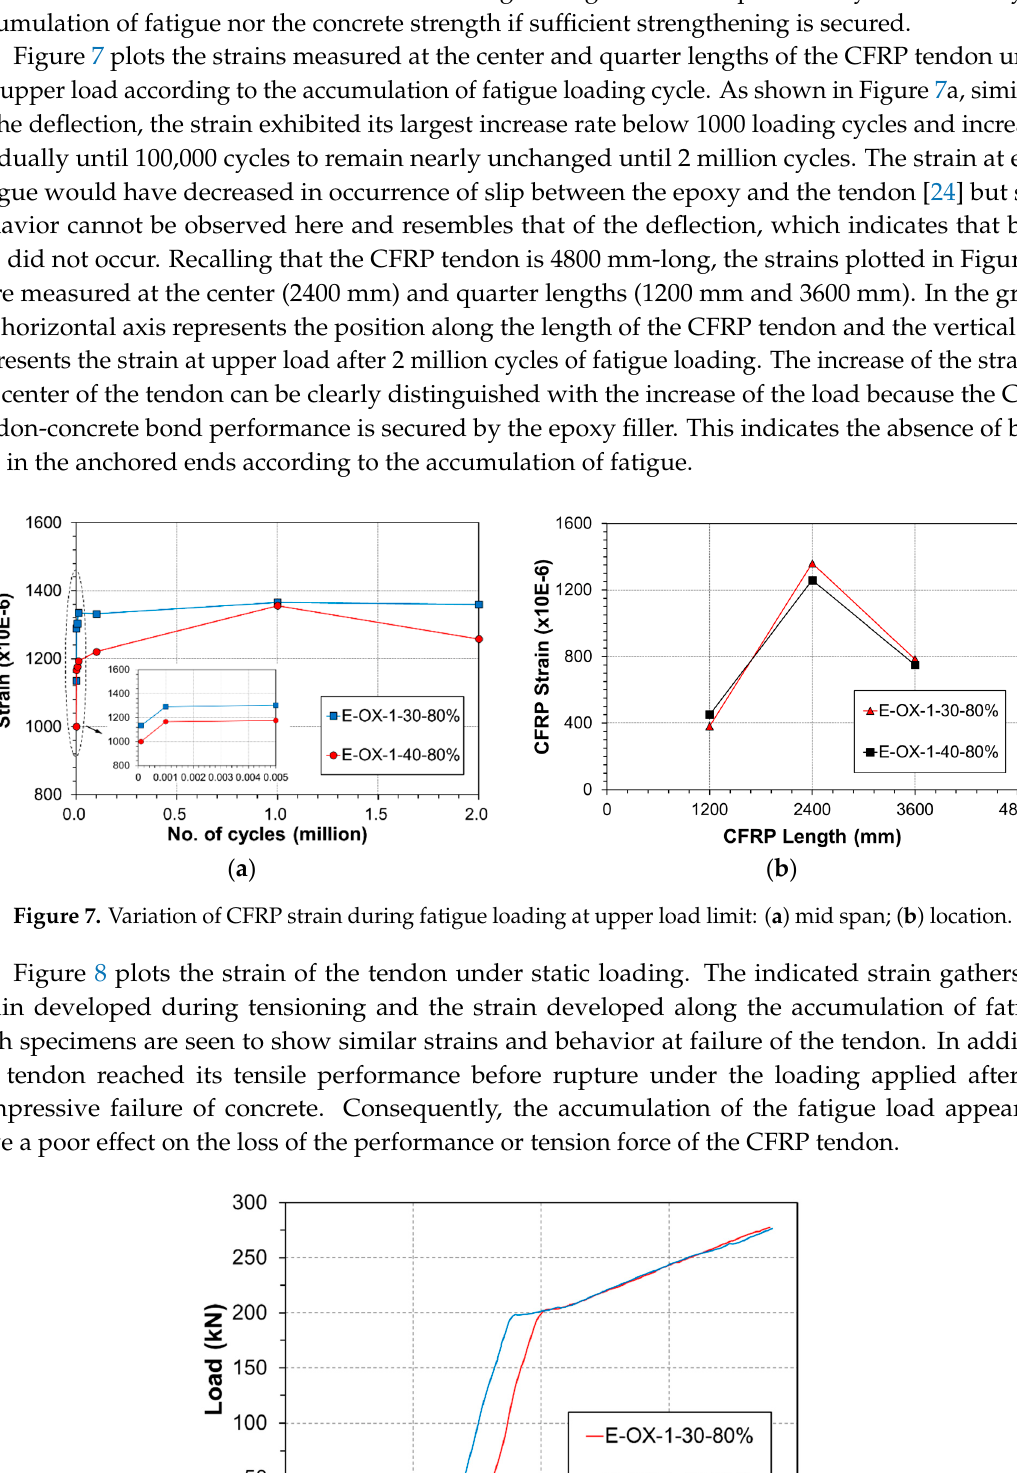
Figure 8. Load-strain relationship at CFRP (Concrete strength).